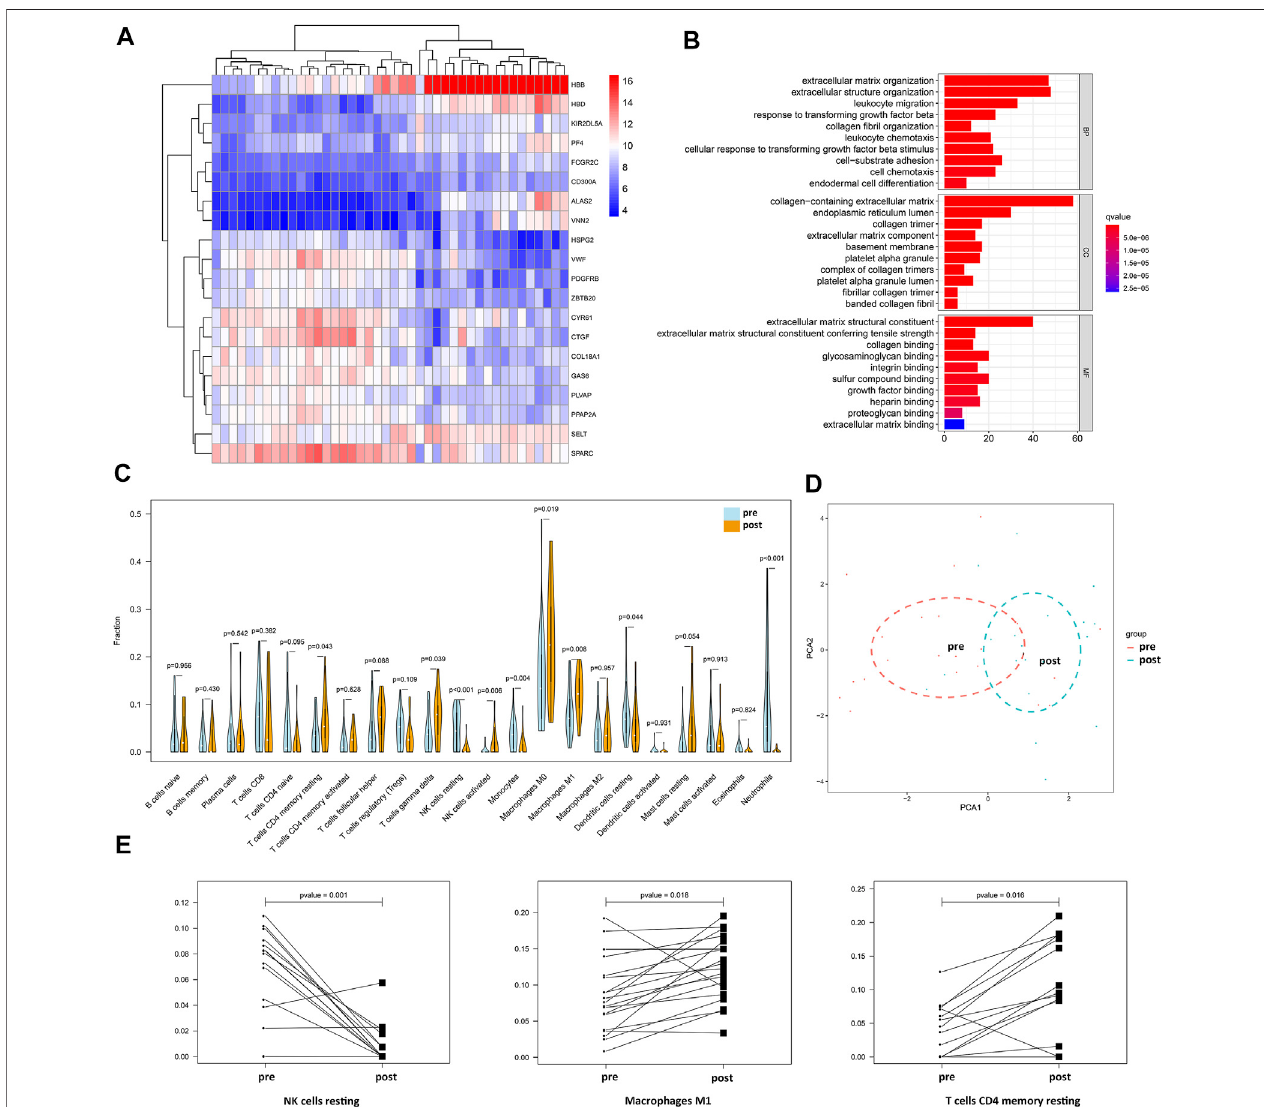
FIGURE 4 | Changes in immune-related genes and immune cell fractions in BC patients before and after NAC. (A) Genetic clustering analysis of the heatmap showedDEGs( p value < 0.05,logFC > 1orlogFC < − 1)withthefoldchangeTOP20fromdatasetGSE32072. (B) BP,CC,andMFofDEGsfromdatasetGSE32072. (C) Differential analysis of 22 immune cell fractions in pre-NAC and post-NAC samples from dataset GSE32072. Blue represents pre-NAC samples and orange represents pre-NAC samples, and p value represents the statistical signi fi cance of the differential analysis between the two groups for each immune cell. (D) PCA cluster analysis showed that the red dots represent the sample before NAC and the blue dots represent the sample after NAC. (E) Paired difference analysis of resting NK cells and M1 macrophages from dataset GSE32072 and CD4 memory resting T cells from dataset GSE18728.